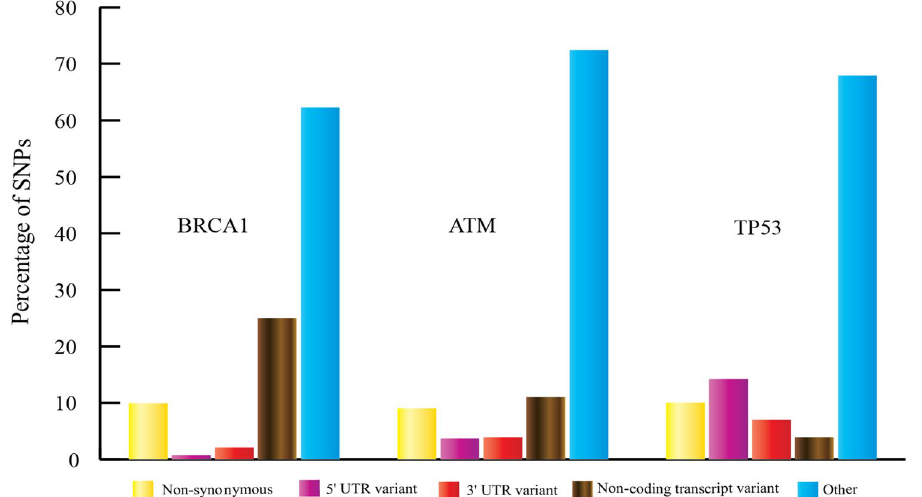
Figure 2. Bar diagram showing the percentages of the SNPs in BRCA1, ATM and TP53 genes. BRCA1 gene had 9.9% nsSNPs, 0.72% 5 ′ UTR SNPs, 2.1% 3 ′ UTR SNPs, 9% non-coding transcript variants and 62.28% other SNPs of total SNPs; ATM gene had 9% nsSNPs, 3.7% 5 ′ UTR SNPs, 3.9% 3 ′ UTR SNPs, 11% non-coding transcript variants and 72.4% other SNPs of total SNPs; TP53 gene had 10% nsSNPs, 14.2% 5 ′ UTR SNPs, 7% 3 ′ UTR SNPs, 3.9% non-coding transcript variants and 67.9% other SNPs of total